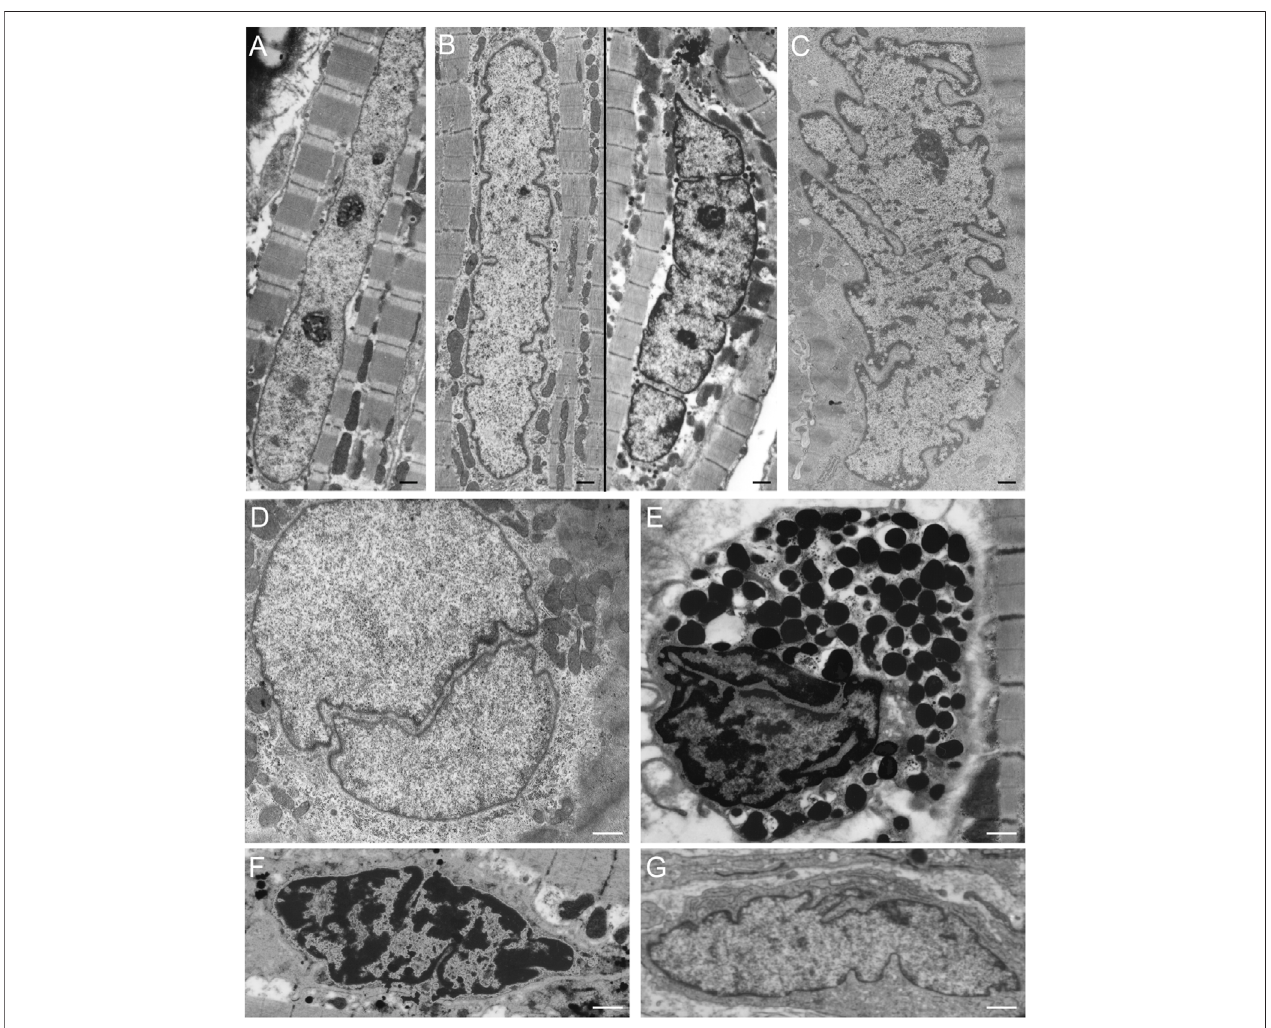
FIGURE 4 | NR-like invaginations of the nuclear envelope in different cardiovascular cell types as seen at the electron microscopy level. (A) Cardiomyocyte in relaxation (goat in vivo atrial tissue), the nuclear membrane shows no invaginations or folds. (B) Cardiomyocyte in mild contraction (goat in vivo atrial tissue), the nuclear membrane shows some folds. (C) Cardiomyocyte in strong contraction (goat in vivo atrial tissue), the nuclear membrane is strongly folded. (D) Cardiomyocyte in relaxation (goat in vivo atrial tissue) demonstrating a large invagination of the nuclear envelope. (E) Mast cell in cardiac tissue (human ventricle), the nuclear membrane has large invaginations. (F) Capillary endothelial cell in cardiac tissue (human ventricle) with several invaginations of the nuclear envelope. (G) Fibroblast in cardiac tissue(human ventricle),thenuclearmembraneisstrongly folded. Scalebars indicate 1 μ m. Goat atrialsampleswere fi xedfor2 hin3%glutaraldehydebuffered to pH 7.4 with 90 mM KH 2 PO 4 . Thereafter the samples were washed in the same buffer for 24 h and post- fi xed for 1 h in 2% OsO 4 buffered to pH 7.4 with veronal acetate. Next, the samples were rapidly dehydrated through a graded series of ethanol and routinely embedded in Epon (Driesen et al., 2009). Ultra-thin sections were counterstained with uranyl acetate and lead citrate prior to examination in a Philips CM 100 electron microscope.